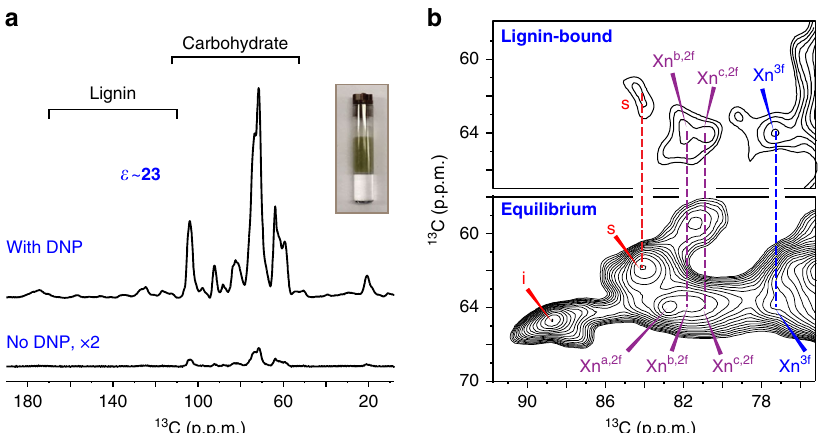
Fig. 4 DNP reveals the conformational selectivity of xylan for lignin-binding. a DNP enhances the NMR sensitivity by 23-fold on maize. The inset shows a representative DNP sample. b Lignin-edited (top) and control (bottom) 13 C – 13 C correlation spectra measured using DNP. The lignin-edited spectrum only shows polysaccharides spatially proximal to lignin, including three-fold and a subset of two-fold xylan (type b and c) and surface cellulose (s)